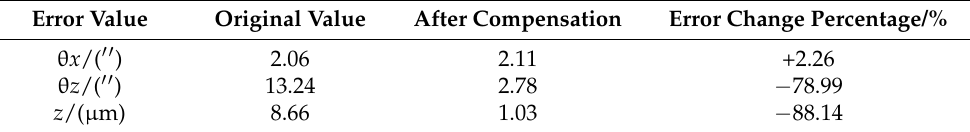
Figure 6. ( a – c ) Position and pose errors without compensation; ( d – i ) position and pose errors after compensation. Table 1. The RMS of the error of the encoder value relative to the true